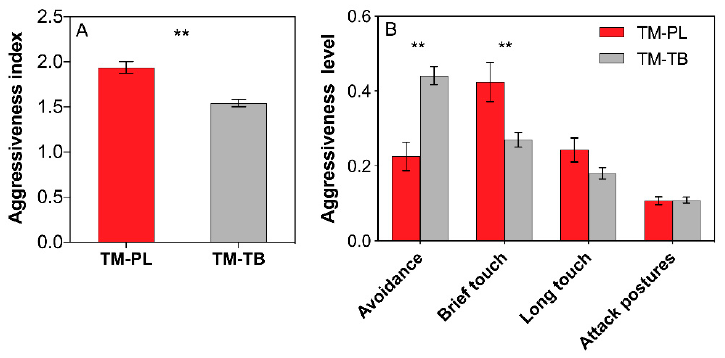
Figure 4. Effects of interference competition on ant aggressiveness. ( A ) aggressiveness index; ( B ) percentage aggressiveness level. The data are presented as the mean ± SE. Asterisk (**) on bars indicate indicates significant differences between the ant treatments ( P < 0.01). Tapinoma melanocephalum - Paratrechina longicornis confrontation and Tapinoma melanocephalum - Tetramorium bicarinatum confrontation were abbreviated into TM-PL and TM-TB, respectively. T. melanocephalum possessed higher exploratory level in original arena but lower exploratory